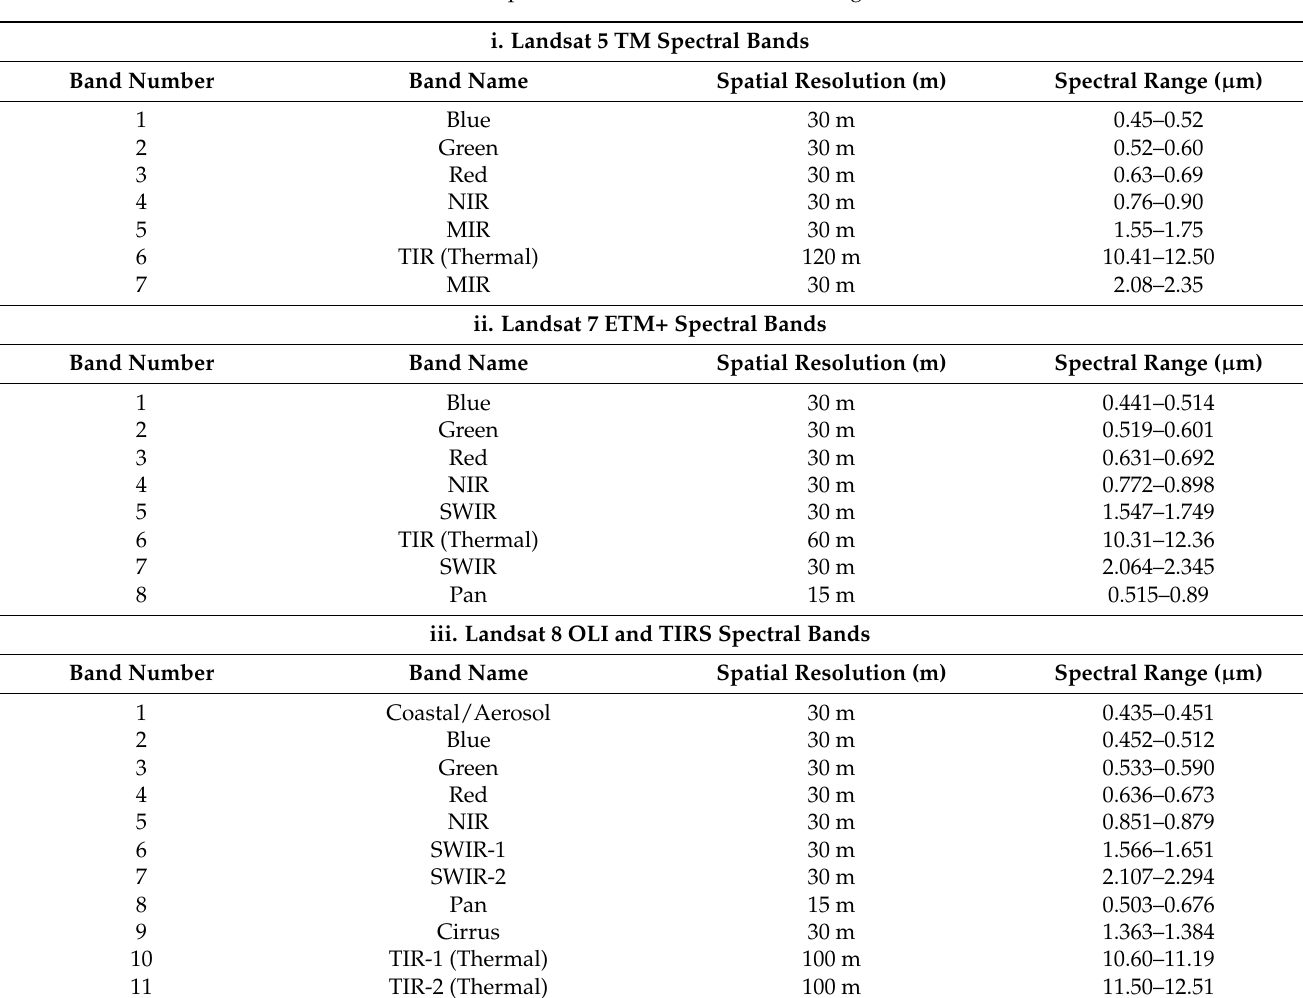
Table 2. Spectral information of satellite